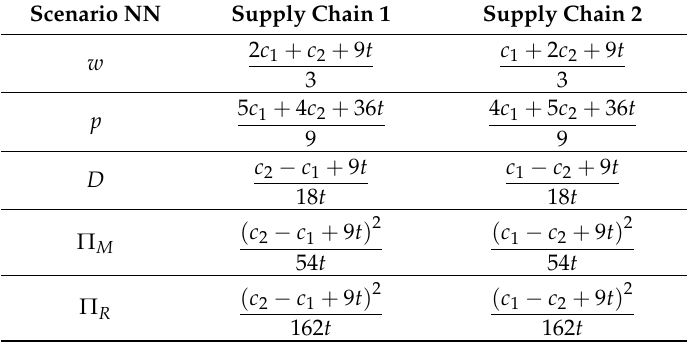
Table A1. Equilibrium outcomes under scenario